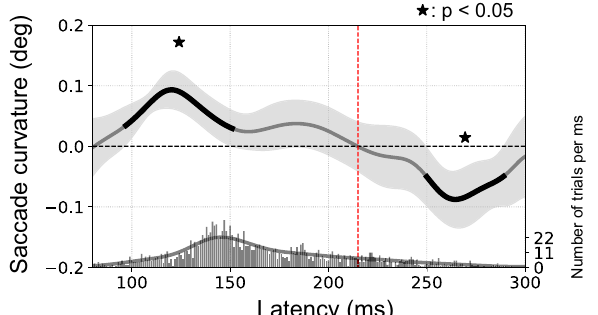
Figure 3. Saccade trajectory curvature as a function of saccade latency. Amount of saccade curvature as a function of latency in the One Distractor / Binocular condition (both ipsilateral and contralateral distractors), averaged across left and right eye dominance groups. Data are smoothed with a Gaussian kernel, with black line segments indicating clusters of time points where a weighted within-subjects t-test resulted in p < 0.05 from zero for the saccade curvature. Asterisks indicate that these clusters survive at the multiple comparisons control at p < 0.05 (see "Methods" for further details). The shaded area is the 95% within-subjects confidence interval. The histogram at the bottom of the graph shows the number of trials per 1 ms bin (right axis, line corresponds to smoothing with the same kernel as above). In agreement with previous studies, curvature was toward the distractor (positive values) for short latency saccades and away from the distractor (negative values) for saccades initiated later. The red dashed line corresponds to the time at which the curvature switch from toward to away (215